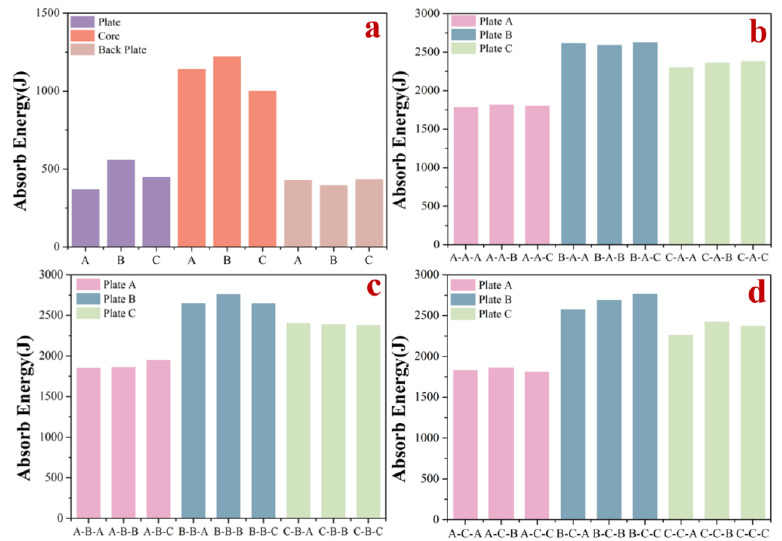
Figure 3. Numerical results. ( a ) Energy absorption statistics of impact resistance of nine components. ( b ) Energy absorption statistics of core A composite structure against impact. ( c ) Energy absorption statistics of Core B composite structure against impact. ( d ) Energy absorption statistics of Core C composite structure against impact.